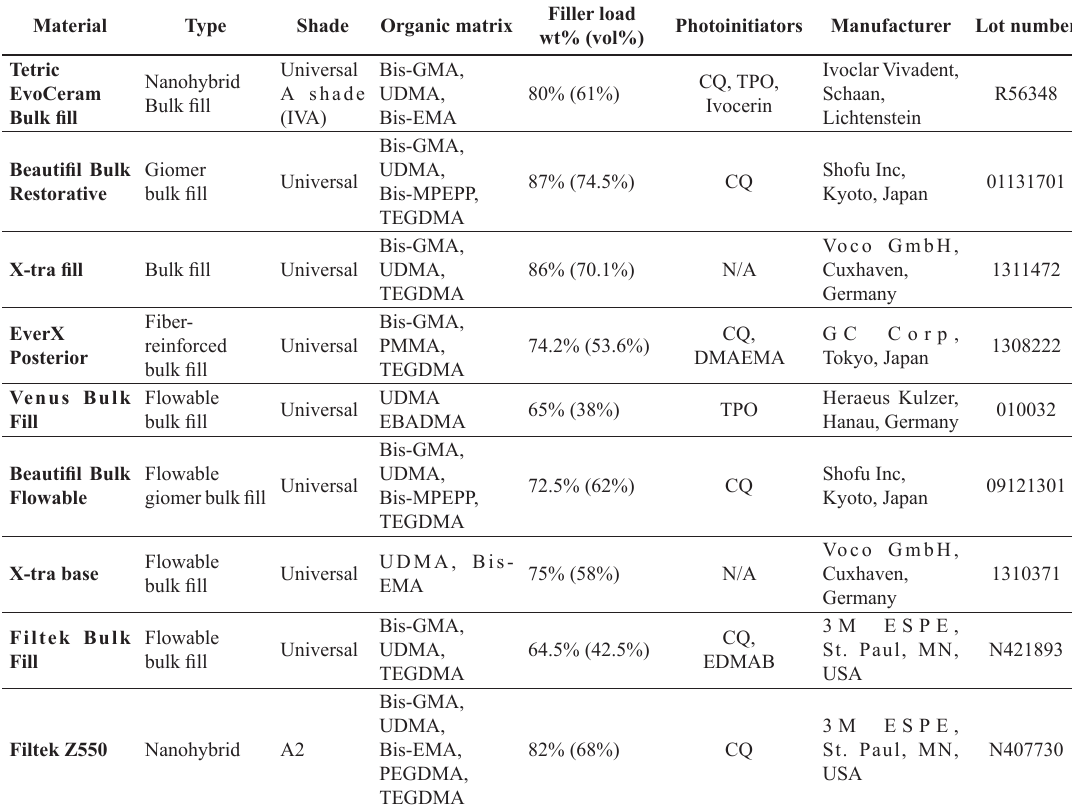
Table 1. The technical characteristics of the composite resins